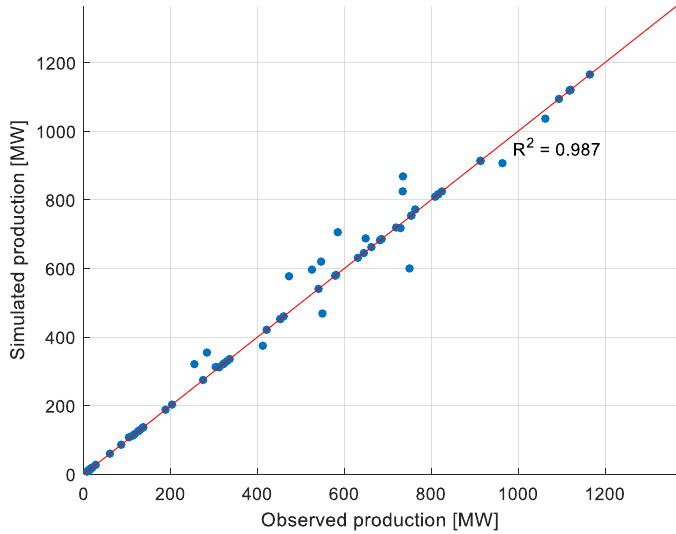
Figure 5. Performance of the neural network for the testing subset. R 2 refers to linear regression. Red line indicates a theoretical perfect match.